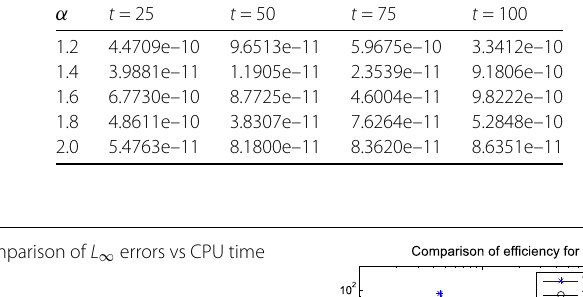
Figure 9 A comparison of L ∞ errors vs CPU time